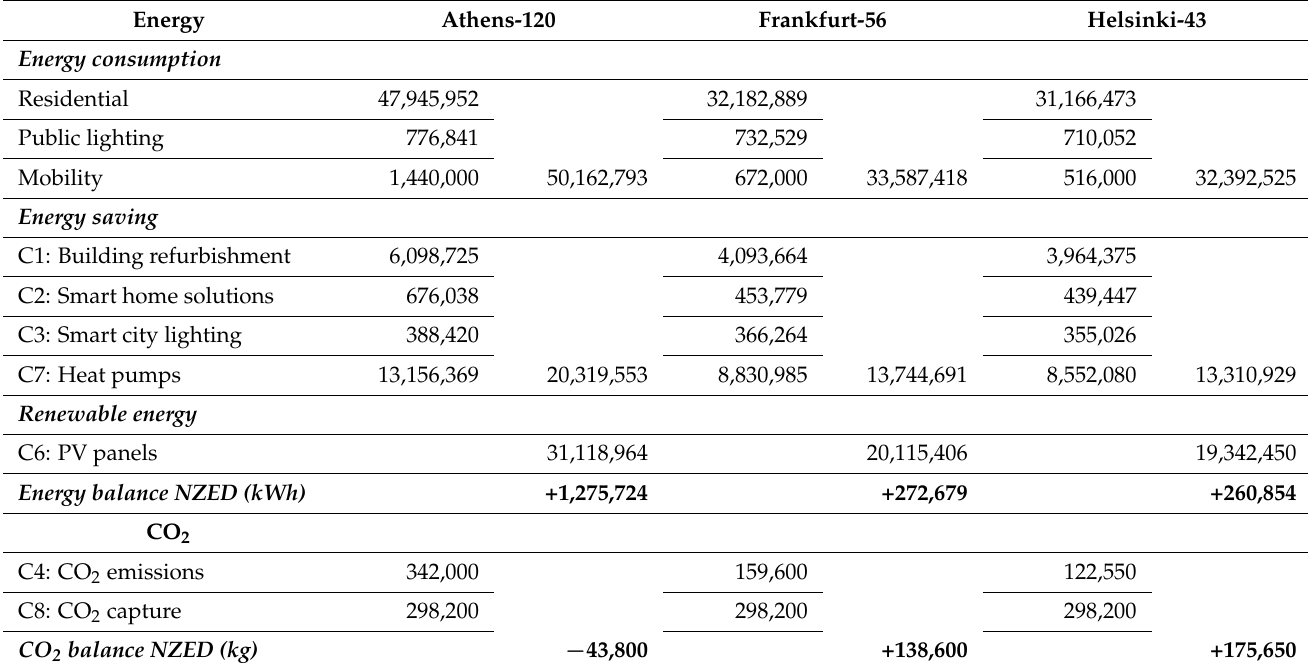
Table 8. Impact of density on NZED